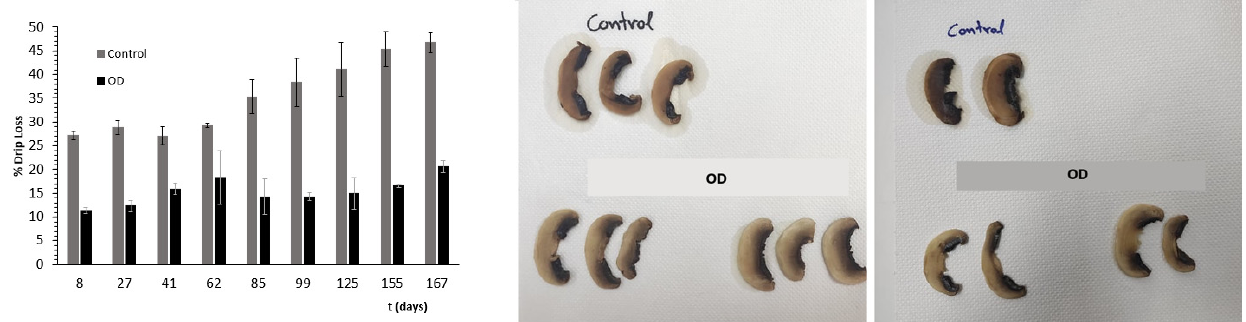
Figure 11. %Drip loss during storage under frozen conditions. Points represent average values, and error bars represent the standard deviation from the three measurements, and photos show the appearance of samples after 60 days (on the left) and 83 days (on the right) of frozen storage.